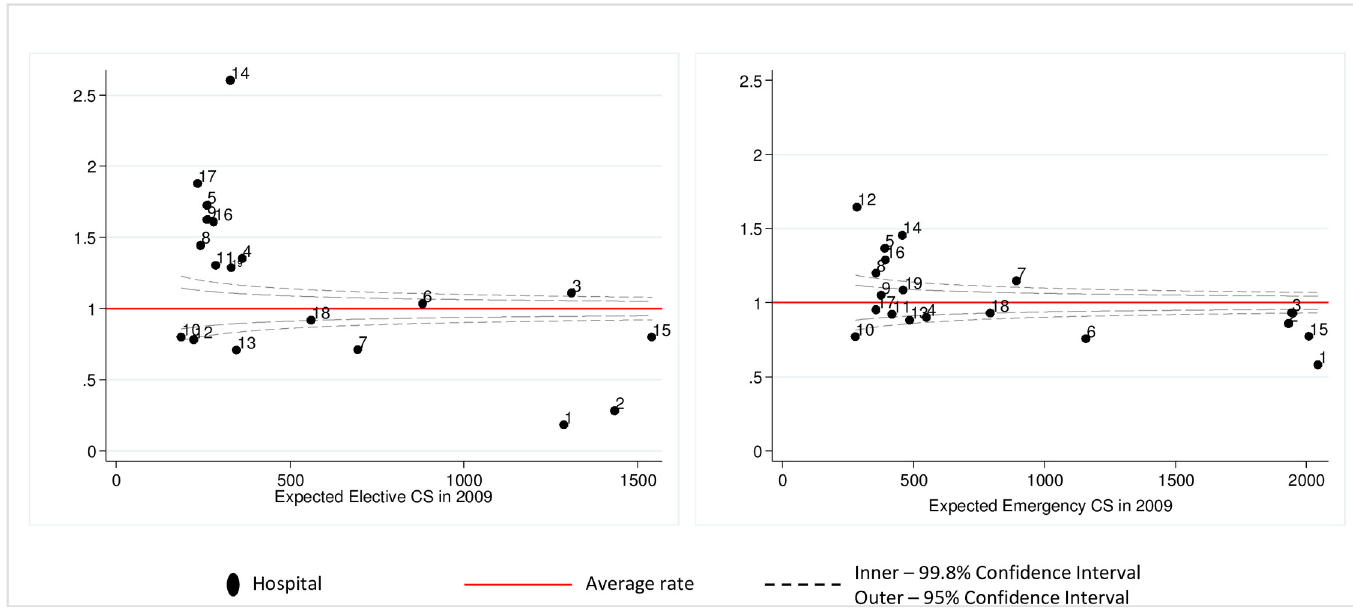
Fig 3. Hospital Standardised Caesarean Section Rates (HSCSRs). CS- caesarean section.